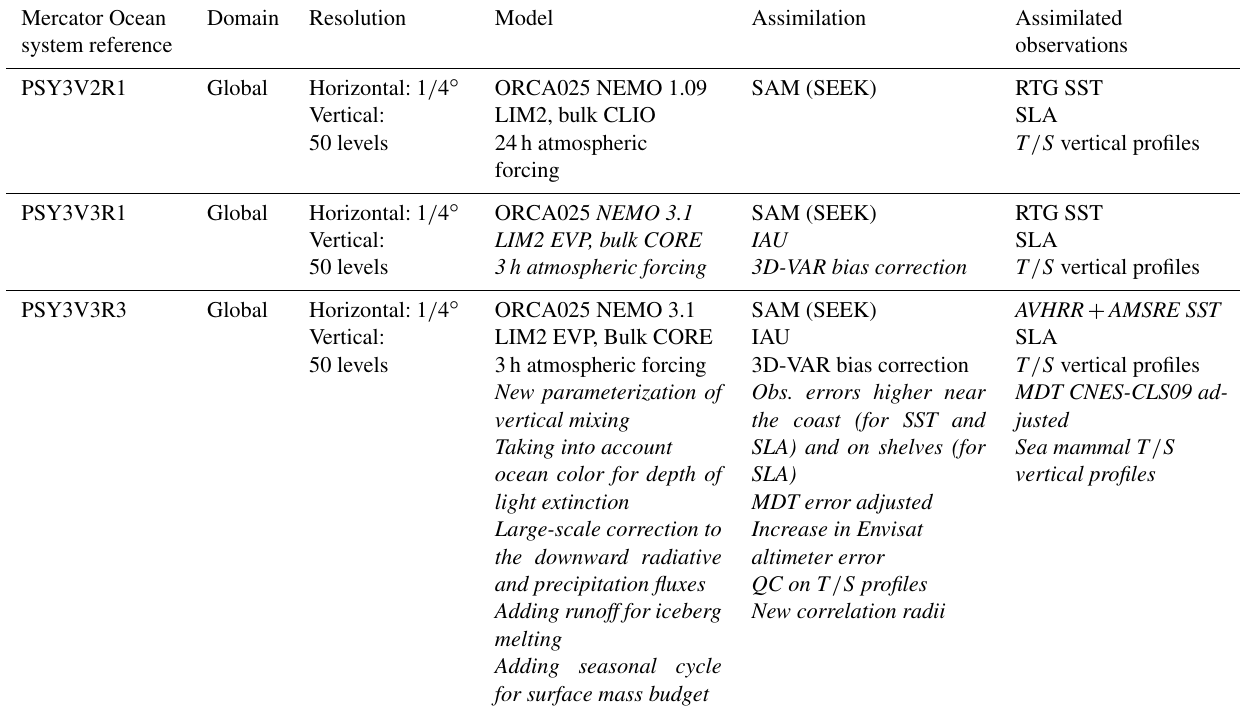
Table 1. Specifics of the Mercator Ocean IRG systems. In italic are the major upgrades with respect to the previous version. Available and operational production periods are described in Fig.